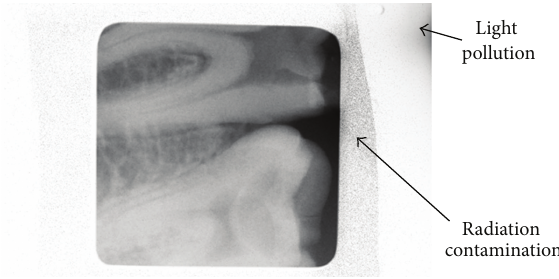
Figure 6: Preventable artifacts obtained in